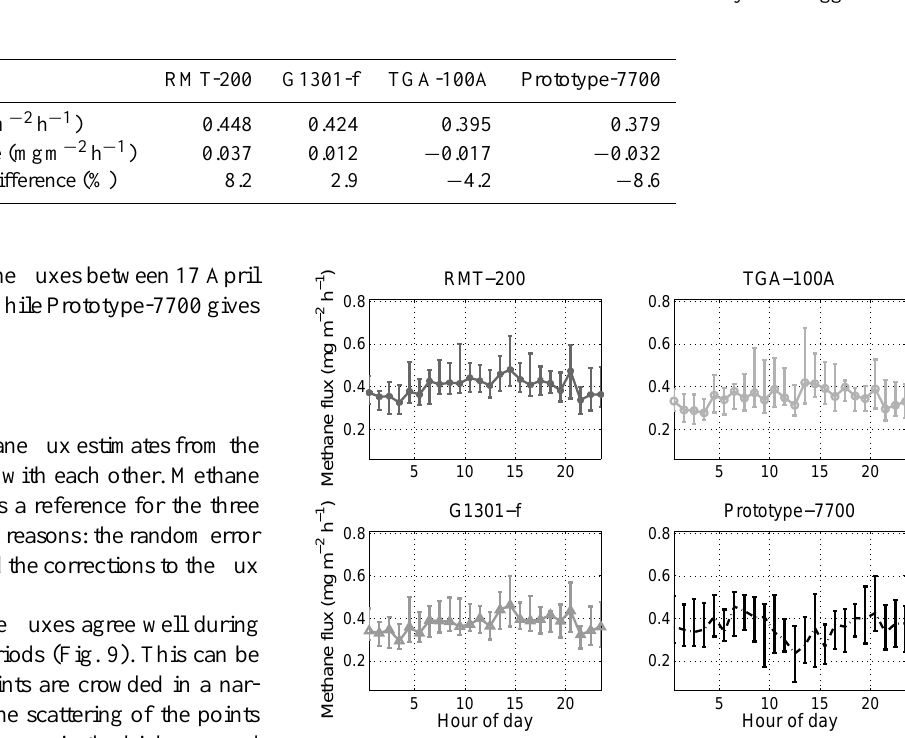
Fig. 8. Median diurnal variation of final fully corrected methane flux obtained from the four methane gas analyzers. Only data from a period when all the instruments were working (17 April–17 May) were used. Data from this period was selected so that the methane fluxes were given quality flag 0. Error bars denote the interquartile range around the median